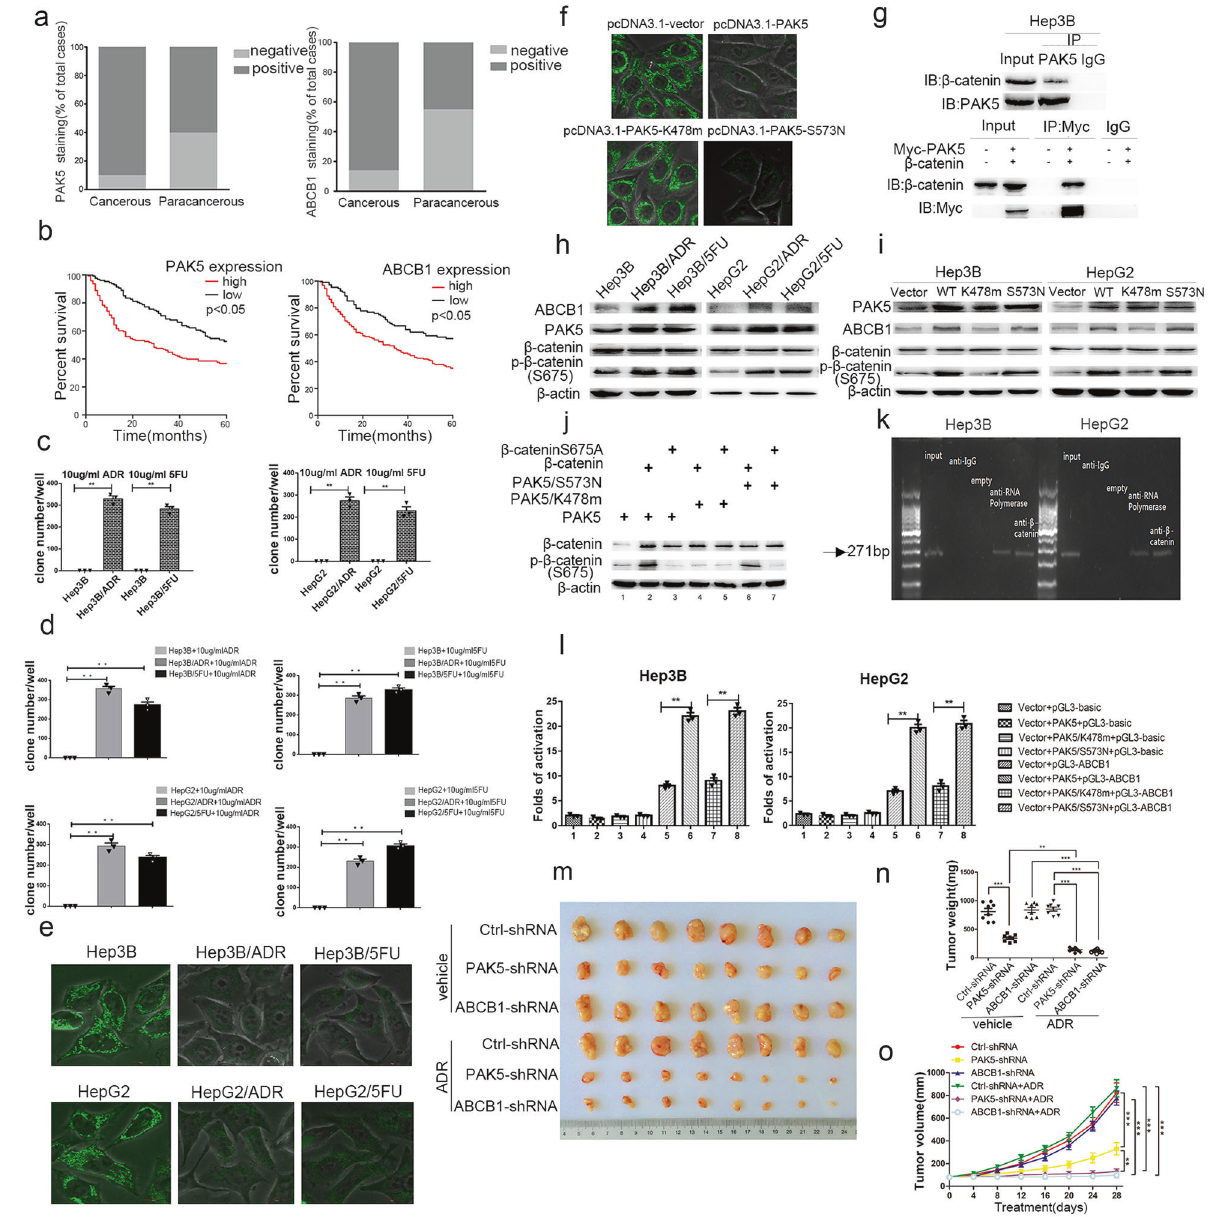
Fig. 1 PAK5-mediated phosphorylation and nuclear translocation of β -catenin facilitates ABCB1 regulation and confers the chemoresistant phenotype in HCC. a PAK5 and ABCB1 expression was higher in HCC cancerous vs. paracancerous tissues. b High PAK5 and ABCB1 expression correlated with worse 5-year survival in HCC patients ( P < 0.05, log-rank test). c Clone formation was elevated in Hep3B- and HepG2-resistant cells. d Colony formation following ADR and 5FU treatment in resistant Hep3B and HepG2 cells was elevated. e Rhodamine staining was decreased in ADR/5FU-resistant cells and ( f ) in Hep3B cells transfected with PAK5, or S573N-PAK5. g Endogenously and exogenously expressed PAK5 immunoprecipitated with β -catenin in Hep3B cells. h ABCB1, PAK5, and phosphorylated β -catenin expression were increased in resistant cell lines. i PAK5, ABCB1, and phosphorylated β -catenin expression were increased in both Hep3B and HepG2 cells transfected with PAK5 or S573N-PAK5. j Cells co-transfected with PAK5/ β -catenin or S573N-PAK5/ β -catenin displayed enhanced β -catenin phosphorylation. k ChIP analysis showed an abundance of β -catenin on the ABCB1 promoter in parental cells. l Luciferase reporter activity was increased in cells transfected with PAK5 or S573N-PAK5. m Representative images of subcutaneous xenograft tumors formed by parental or ADR-resistant Hep3B cells in nude mice treated with or without ADR for four weeks. n , o Tumor weight and volume were decreased in PAK5-silenced and resistant cells. ** P < 0.01, *** P < 0.001